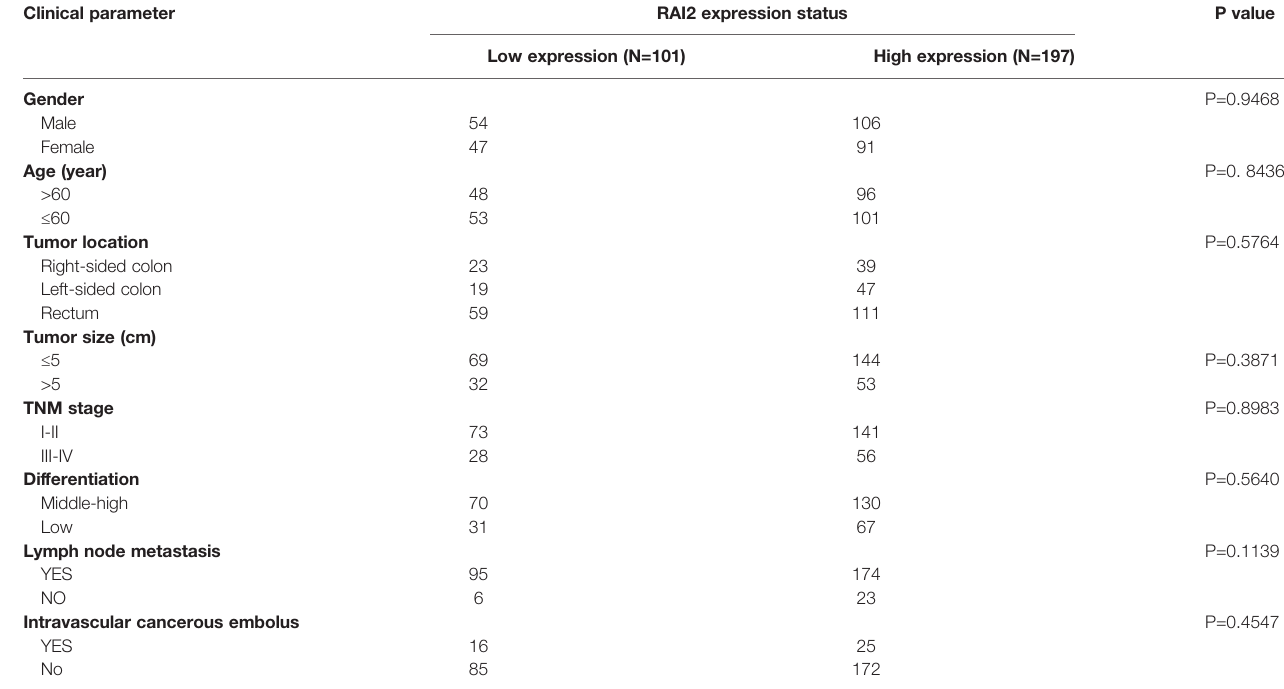
TABLE 1 | Clinical characteristics and RAI2 expression status of 298 patients with colorectal cancer. Clinical parameter